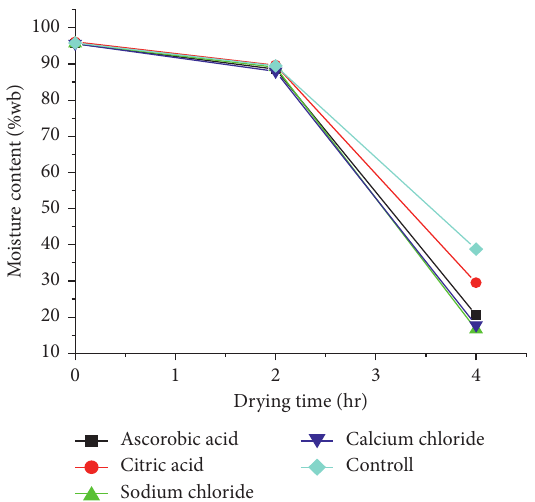
Figure 4: Moisture content (%wb) of pretreated tomato slices versus drying time (hr) during drying in the twin layer solar tunnel